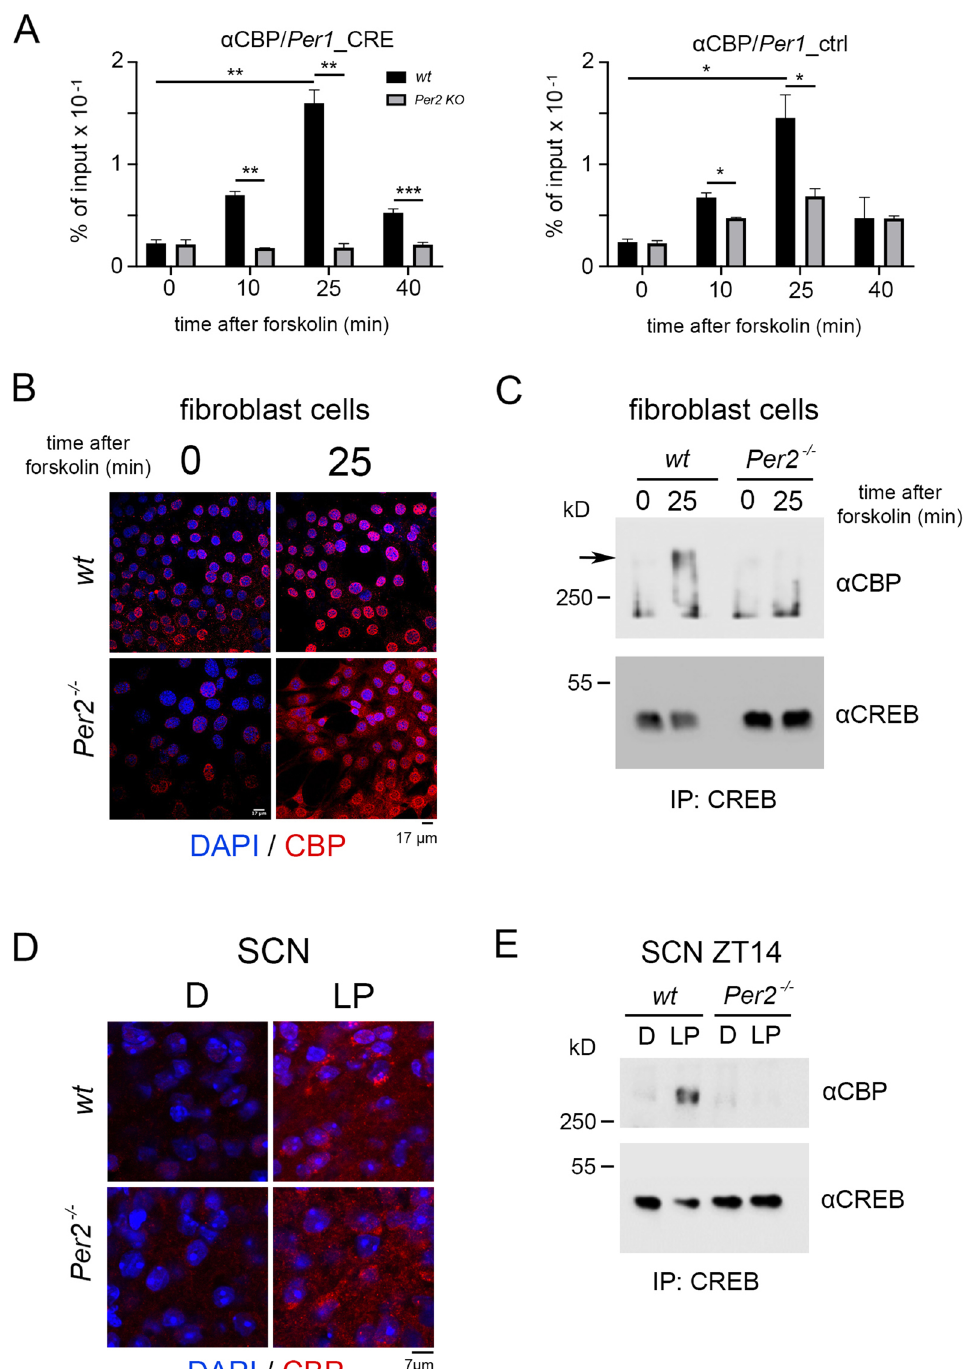
Figure 4. Modulation of the interaction between CREB and CBP by PER2. ( A ) Left panel: Chromatin immunoprecipitation (ChIP) of CBP on the CRE-element of the Per1 promoter in wt (black bars) and Per2 KO (grey bars) fibroblast cell lines after forskolin treatment. Right panel: Control ChIP on a promoter region of Per1 without a CRE-element . Values are the mean ± SD. Student’s t-test with Welch’s correction, n = 3, * p < 0.05, ** p < 0.01. Two-way ANOVA indicates a significantly different time profile between the two genotypes, left panel: **** p < 0.0001, right panel: ** p < 0.01. ( B ) Immunohistochemistry (IHC) of wt and Per2 -/- cells before and after forskolin treatment. CBP (red signal) is induced after forskolin treatment in both genotypes. Scale bar: 17 µm. ( C ) IP of CREB pulls down CBP in wt but not Per2 -/- cells after forskolin treatment, kD = kilo Dalton. ( D ) IHC of wt and Per2 -/- SCN before and after a light pulse (LP) at ZT14. CBP (red signal) is induced after LP in both genotypes. Scale bar: 7 µm. ( E ) IP of CREB pulls down CBP in wt SCN extracts after LP, but not in Per2 -/- SCN extracts. kD = kilo